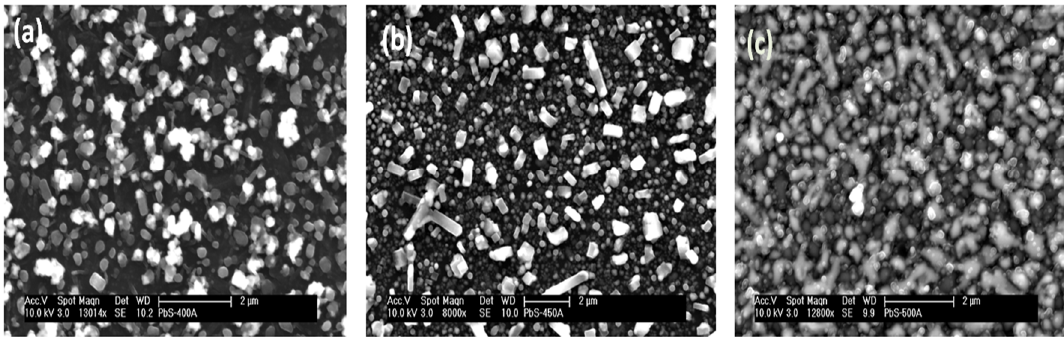
Figure 2. SEM images of PbS thin depositions at: ( a ) 400 °C; ( b ) 450 °C; ( c ) 500 °C.